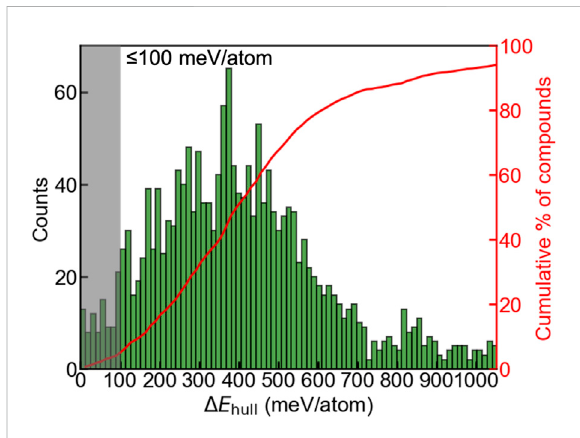
FIGURE 2 Distribution (left y -axis) and the cumulative fraction (right y -axis) of the A x = 0, 1, 2) oxyhydrides as a function of 2 BH 1+ x O 3- x ( Δ E hull . The shaded area indicates the oxyhydrides with 100 meV/atom and a high likelihood of experimental